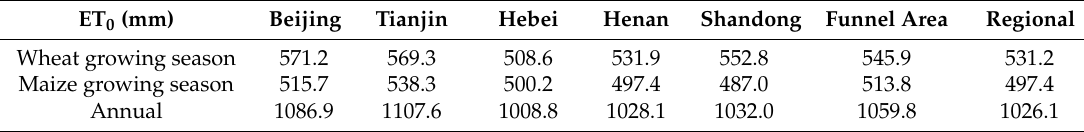
Figure 8. The spatial distribution of the long-term average reference evapotranspiration (ET 0 ) on ( a ) the winter-wheat growing season; ( b ) the summer-maize growing season and ( c ) the annual basis. Table 7. The province-wide, funnel area, and regional statistics for the wheat, maize, and annual average reference evapotranspiration.